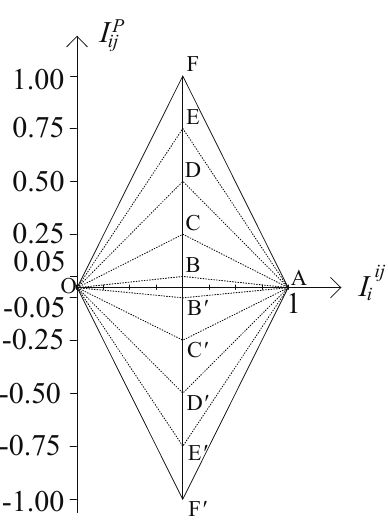
Figure 1. Refined diamond diagram.